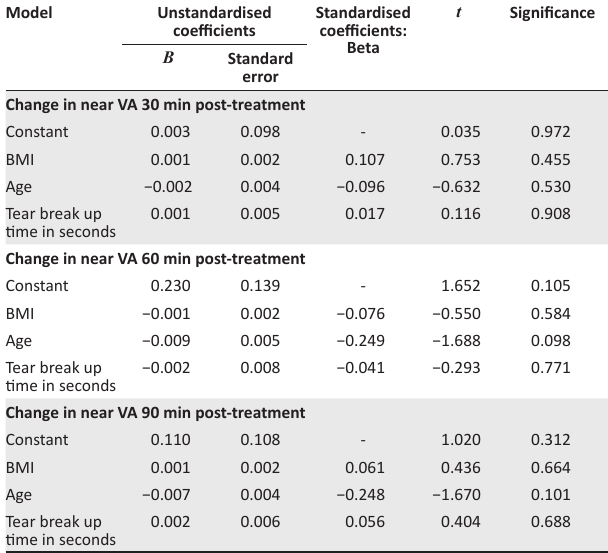
TABLE 1 : Multiple regression analysis: Body mass index, age and tear break up time versus change in near visual acuity post-treatment.